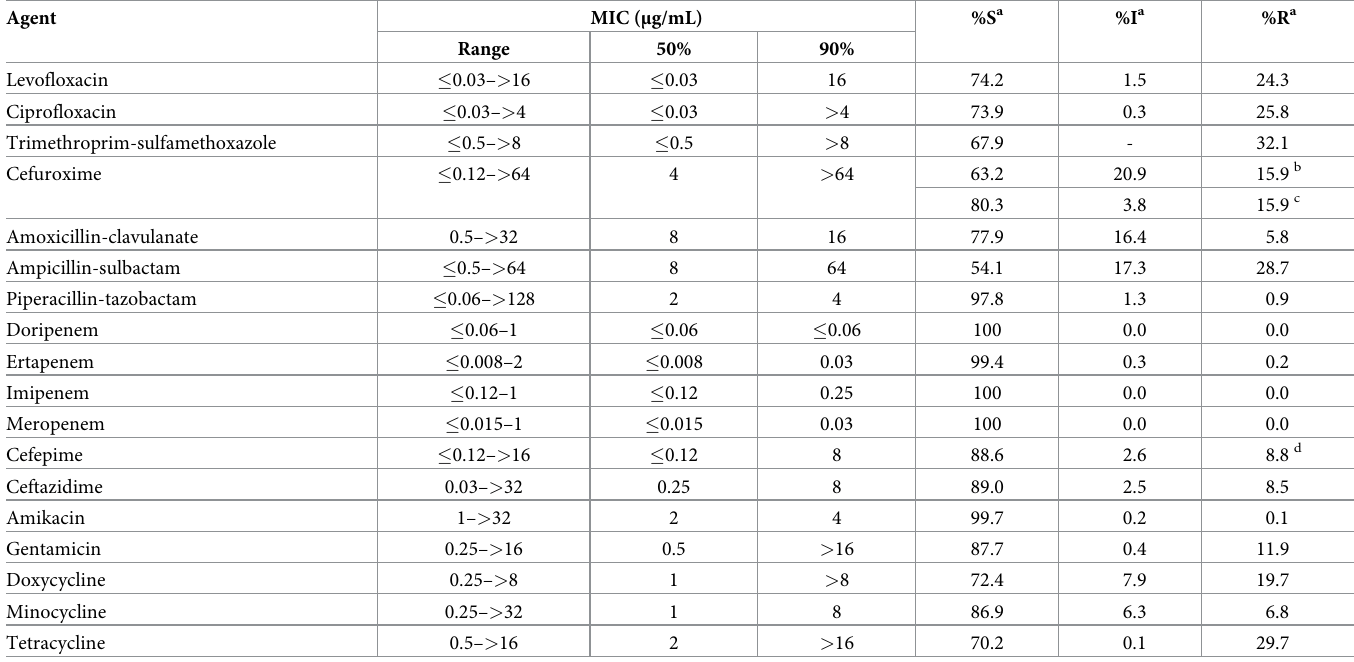
Table 1. Susceptibility results for 1831 isolates of E . coli from urinary tract infections collected in the USA in 2017 (SENTRY Antimicrobial Surveillance Program).